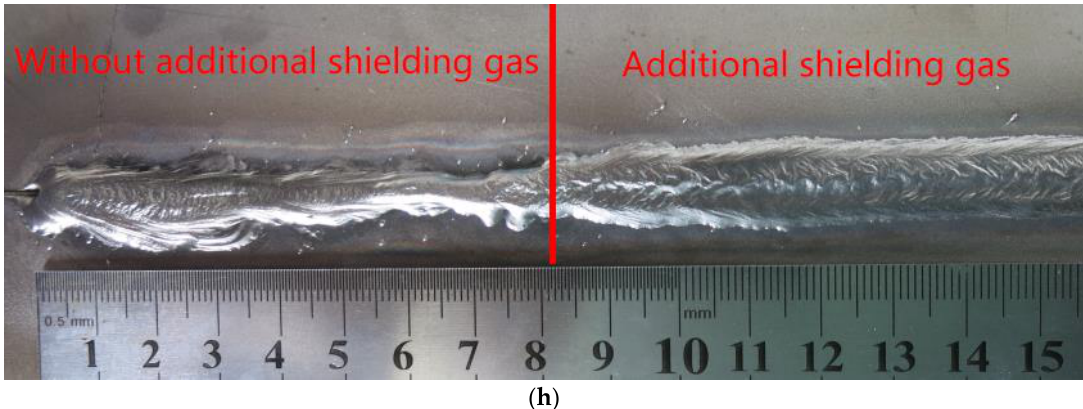
Figure 3. Morphology of the weld seam: ( a ) Penetration depth and width/depth, ( b ) The cross-section of joint of Sample 1, ( c ) The cross-section of joint of Sample 2, ( d ) The cross-section of joint of Sample 3, ( e ) The cross-section of joint of Sample 4, ( f ) The cross-section of joint of Sample 5, ( g ) The cross-section of joint of Sample 6, ( h ) the comparison before and after the introduction of additional shielding gas.